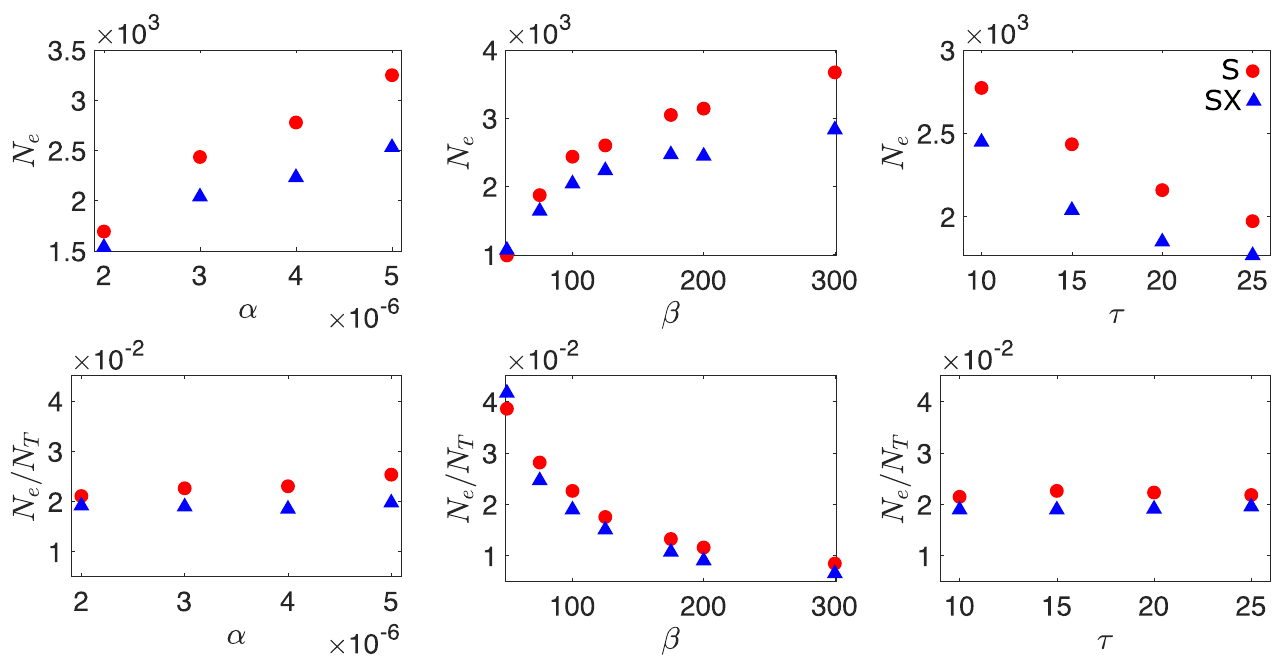
Fig 2. Effective population size. The effective population size in both superinfecting (S) and superinfection-excluding (SX) populations as a function of adsorption rate α , burst size β and lysis time τ . Effective population size are also shown scaled by the size of the total phage population N T = ( V ss + β I ss ). Parameters used were α = 3 × 10 − 6 , β = 100 and τ = 15 unless otherwise stated. Throughout, δ = 0.1 and B 0 = 1000. Error bars are plotted but are too small to see. The data is obtained from an average of at least 1000 independent simulations.